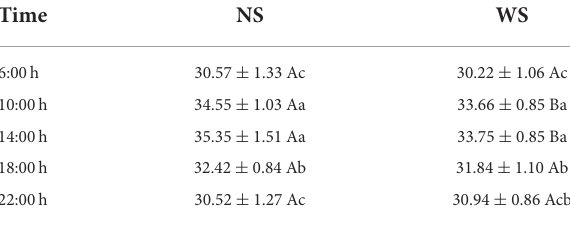
TABLE 5 Values of average ( ◦ C) body surface temperature (BST) ± standard deviation of standard female buffaloes raised in the sun (NS group) and in the shade (WS group), at different times of the day, in the rainy season, on Ilha do Marajó,